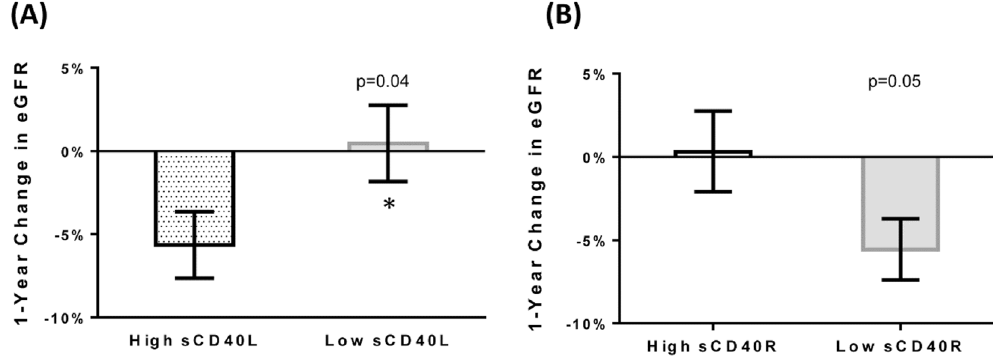
Figure 1. Percent Change in eGFR in the CRISIS Cohort Dichotomized by Median sCD40L or sCD40R at 1-Year Follow-up. ( A ) Subjects were dichotomized by median sCD40L (205.0 [142.4, 324.6] pg/mL) or ( B ) by median sCD40R (81.4 [50.9, 306.0] pg/mL).